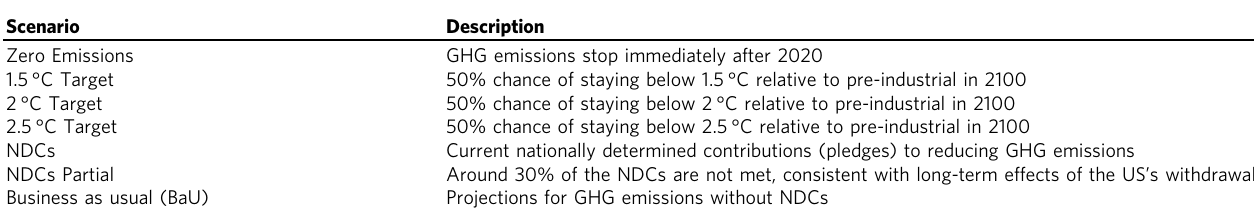
Table 1 Climate and socio-economic scenarios obtained by pairing RCPs with SSPs Scenario Description Zero